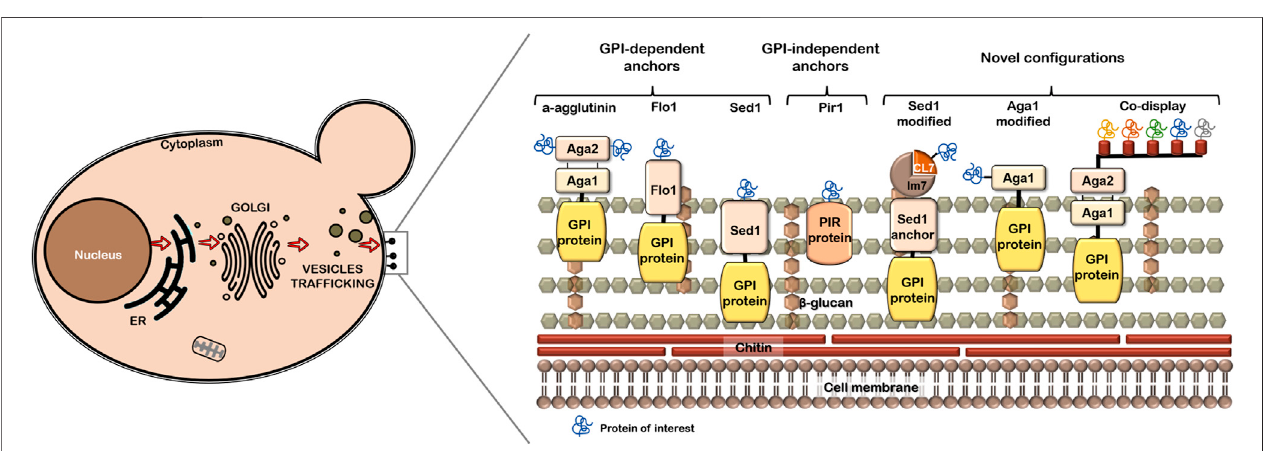
FIGURE1| Schemeofcellwallproteins used asanchors inYSD system. Common anchors and themodi fi edonesare shownin arepresentation